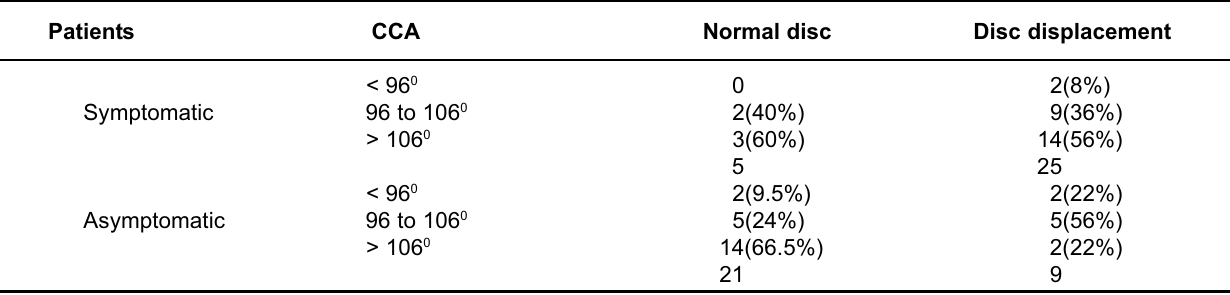
TABLE 3- Distribution and classification of the TMJs of symptomatic and asymptomatic individuals, with and without articular disc displacement, in relation to craniocervical angle values Patients